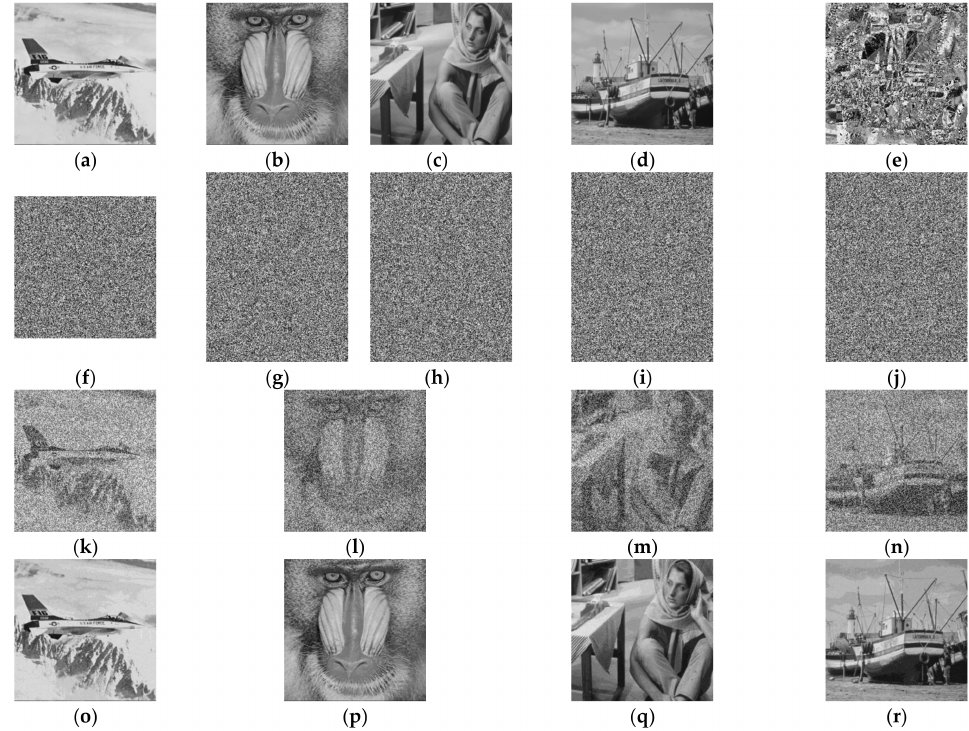
Figure 5. A (4, 3, {2, 3, 4}) XOR-based progressively secret image sharing example, ( a – d ) the secret images, ( e ) XOR result of ( a – d ), ( f ) the generated random image, ( g – j ) shared images, ( k – n ) recovery results by using ( g – h ), ( o – r ) recovery results by using ( g – i